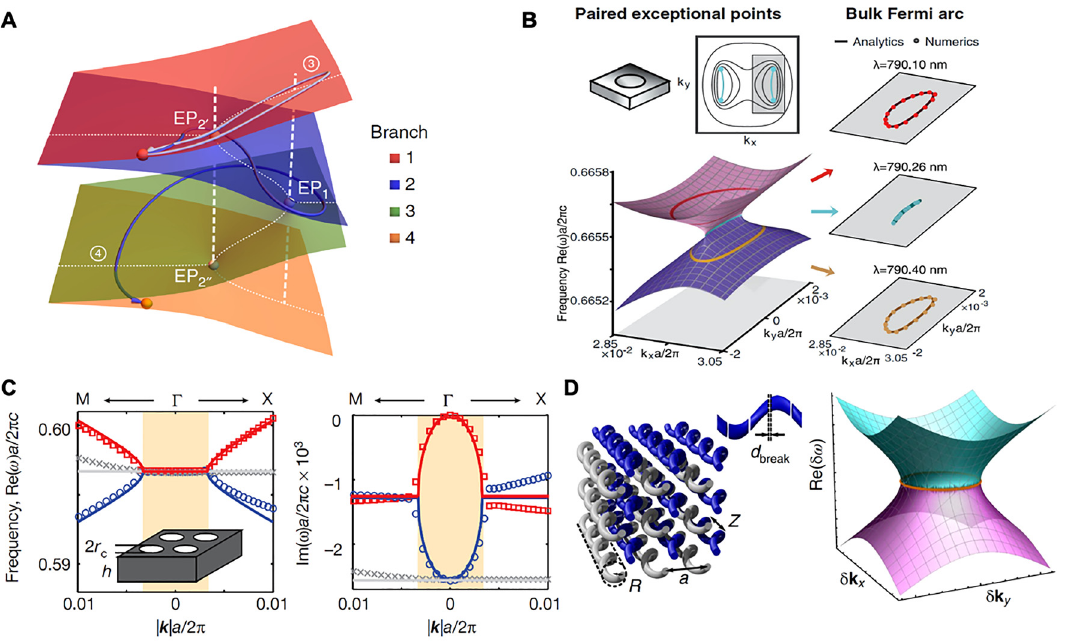
Figure 4: Exceptional rings and higher-order effects. (A)Exceptionalpoint(EP)encirclementintheparameterspaceofasystemsupportingtwoEPs.Inthiscase,nonhomotopicloopsencirclingEP1